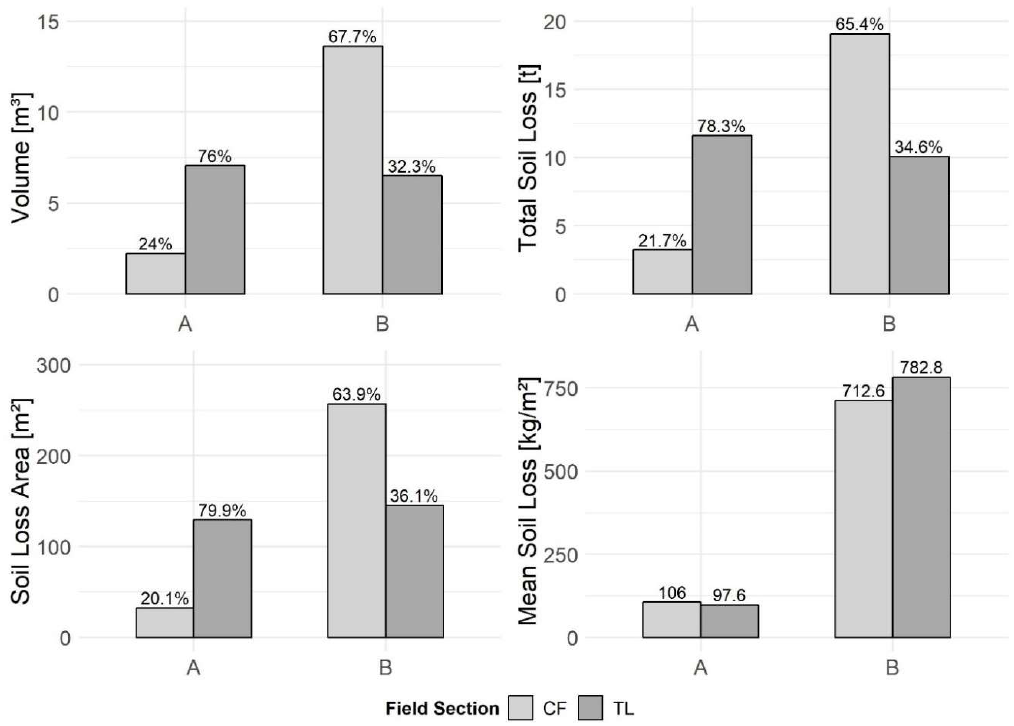
Figure 9. Results from soil erosion measurements from rills of the investigated rainfall event for fields ( A ) and ( B ), separated in cultivated field (CF) and tramline section (TL).